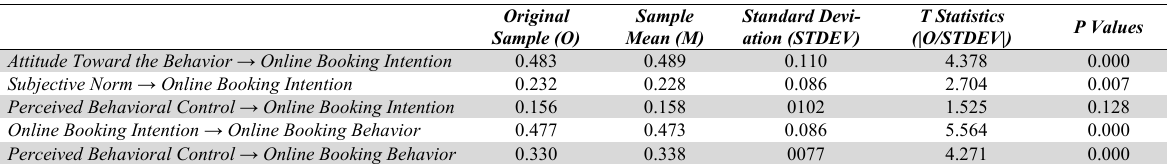
Direct effect test